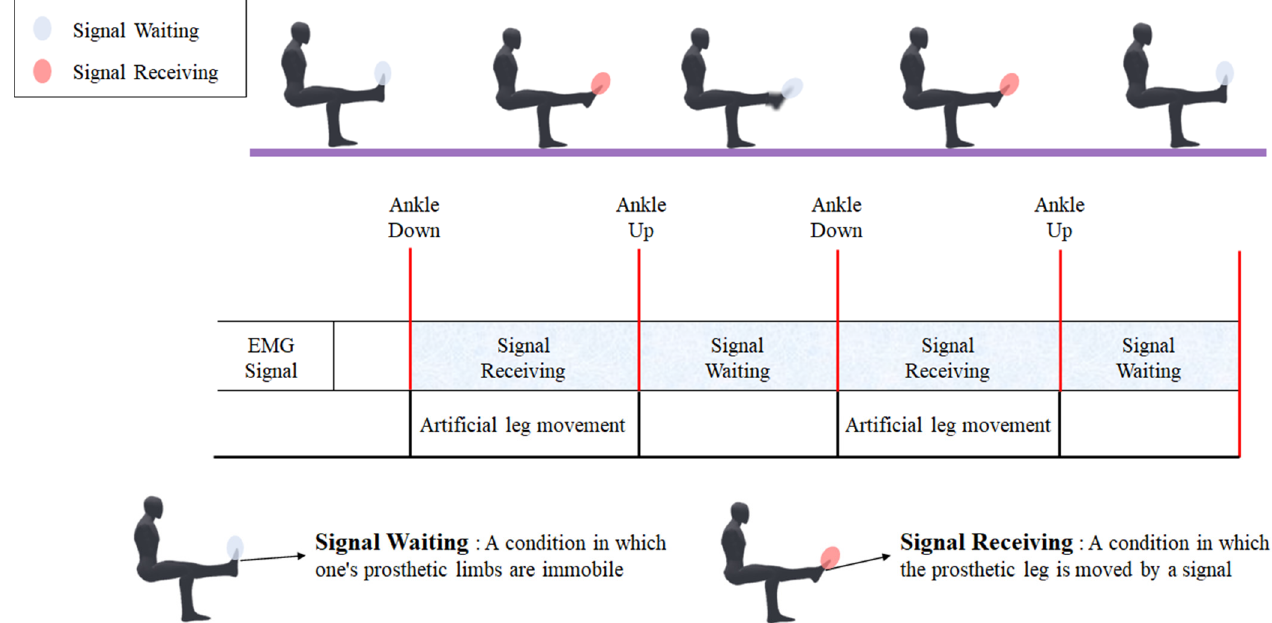
Figure 7. Rehabilitation Process for Patients with Lower Extremity Amputation.